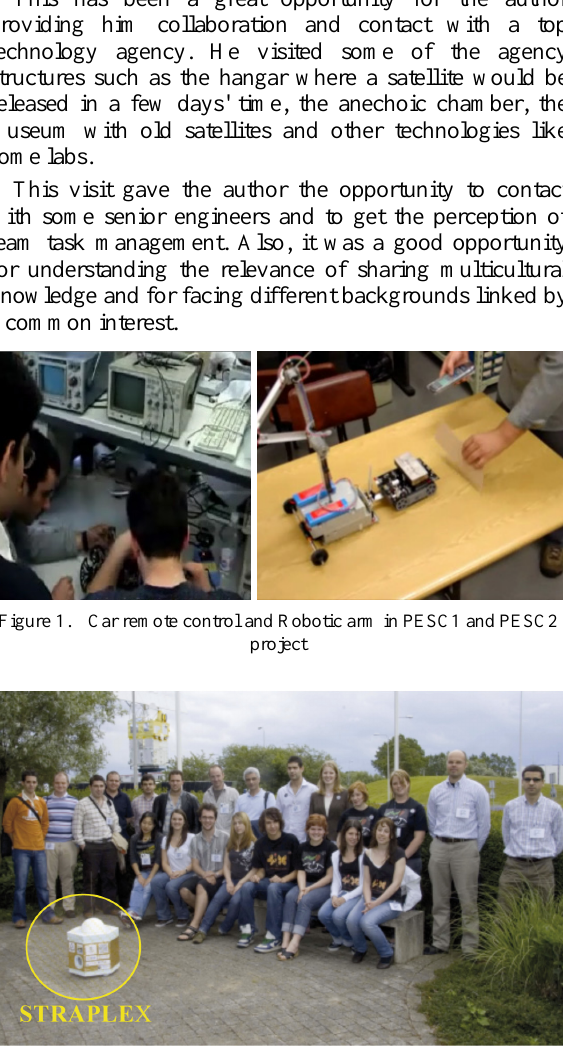
Figure 2. STRAPLEX workshop participants, Noordwijk,